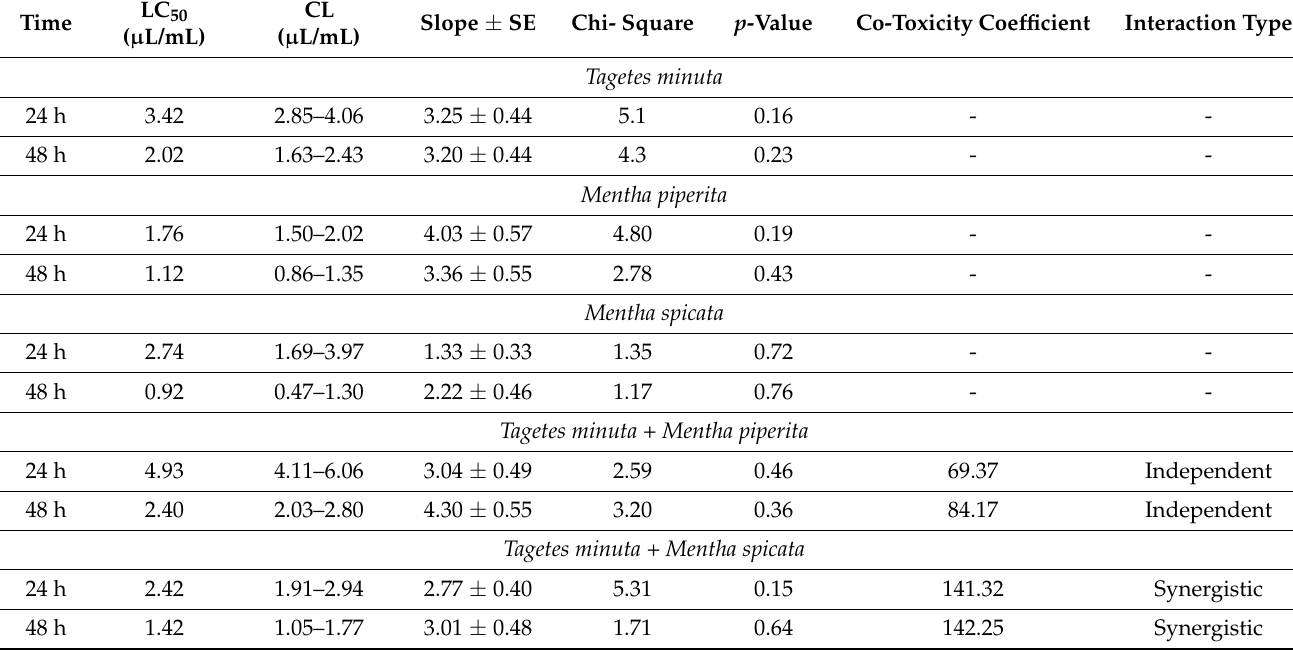
Table 2. Fumigant toxicity of essential oils and their combination against Callosobruchus maculatus